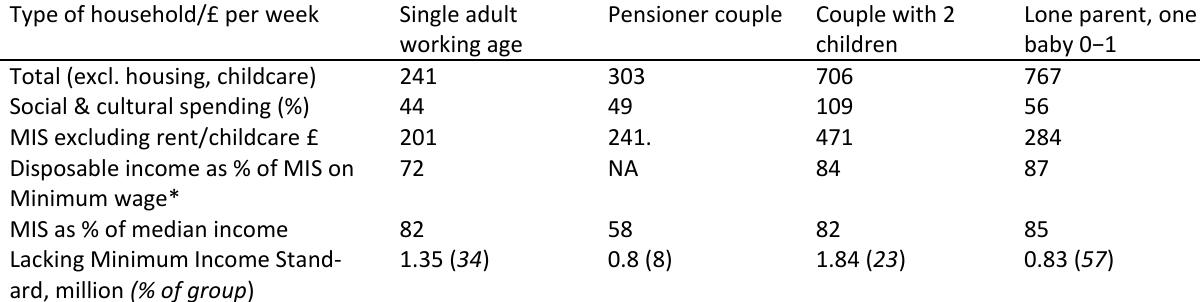
Table 2. Family expenditure on recreation 2011.